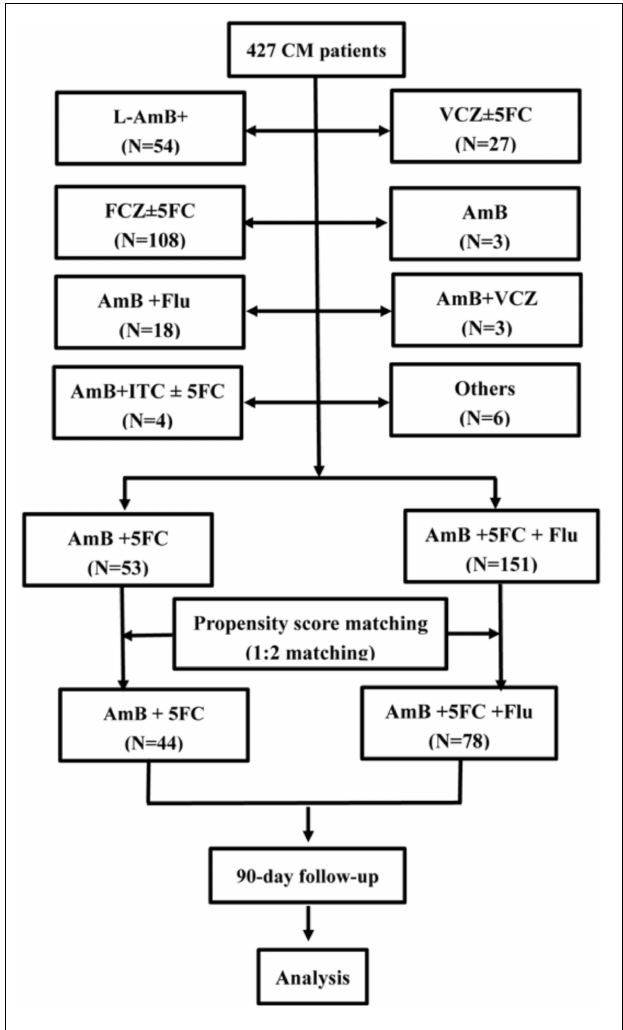
FIGURE 1 | Flowchart of patient